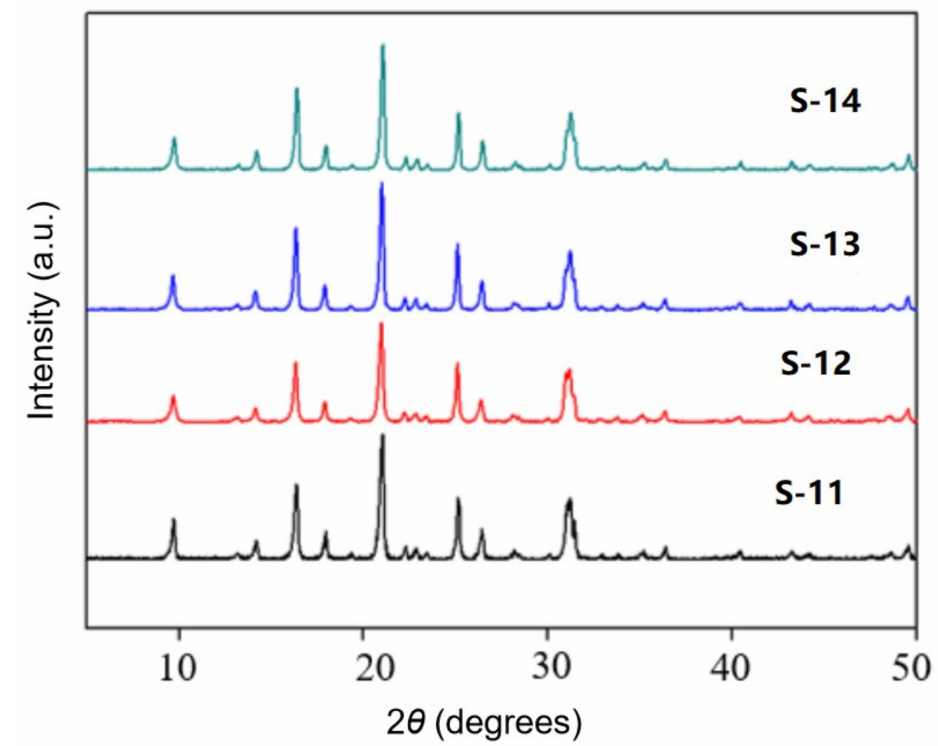
Figure 8. XRD patterns of samples S-11, S-12, S-13 and S-14.